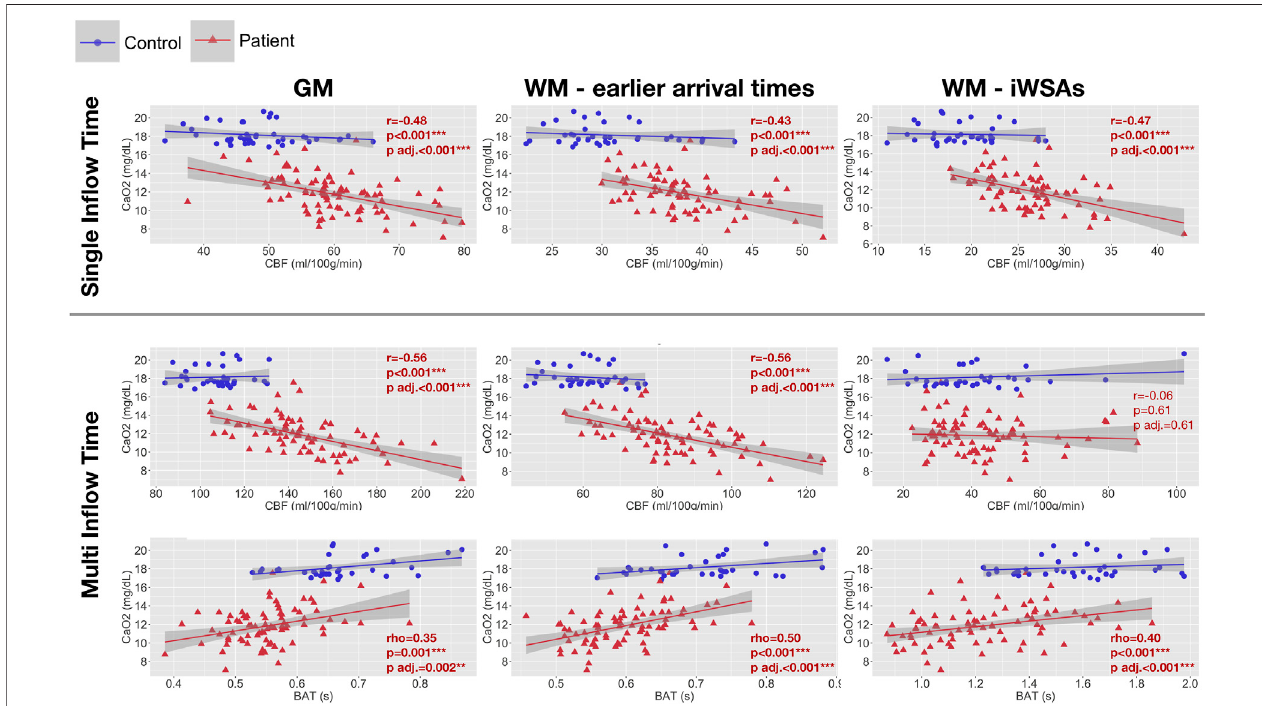
FIGURE 6 | Correlations with arterial oxygen content. Scatterplots showing the relationship between arterial oxygen content and age- and sex-adjusted mean cerebral blood fl ow (CBF) and bolus arrival time (BAT) based on the single- and multi-in fl ow time sequences (rows) across different regions of interest (columns) in patients with sickle cell anemia (shown in red). Pearson ’ s correlation coef fi cients (r), Spearmans Rho (r) and p -values (p) adjusted within parameter types for multiple comparisons using the Benjamini and Hochberg false discovery rate (p adj.) are displayed. Abbreviations: GM, gray matter; WM, white matter; iWSAs, individual watershed